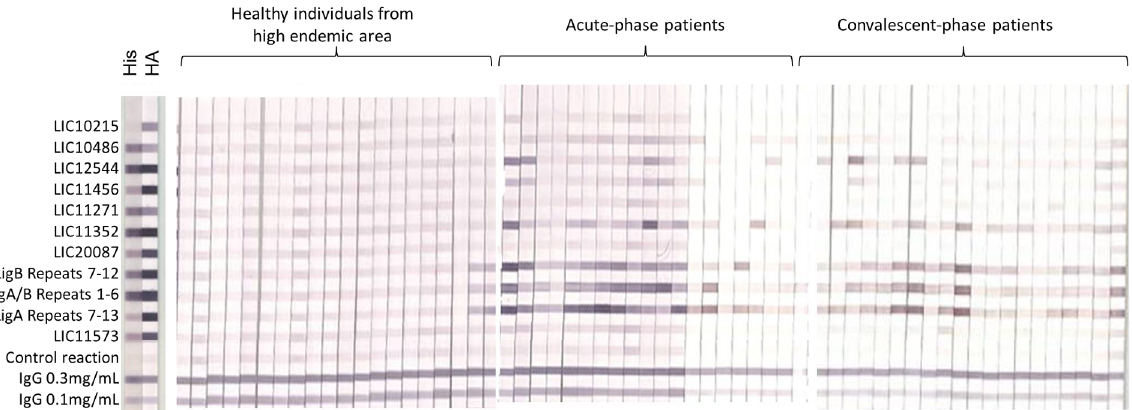
Figure 5. Array validation by immunostrips probing. Strips are grouped by sample type. Probing for His and HA tags are highlighted on the